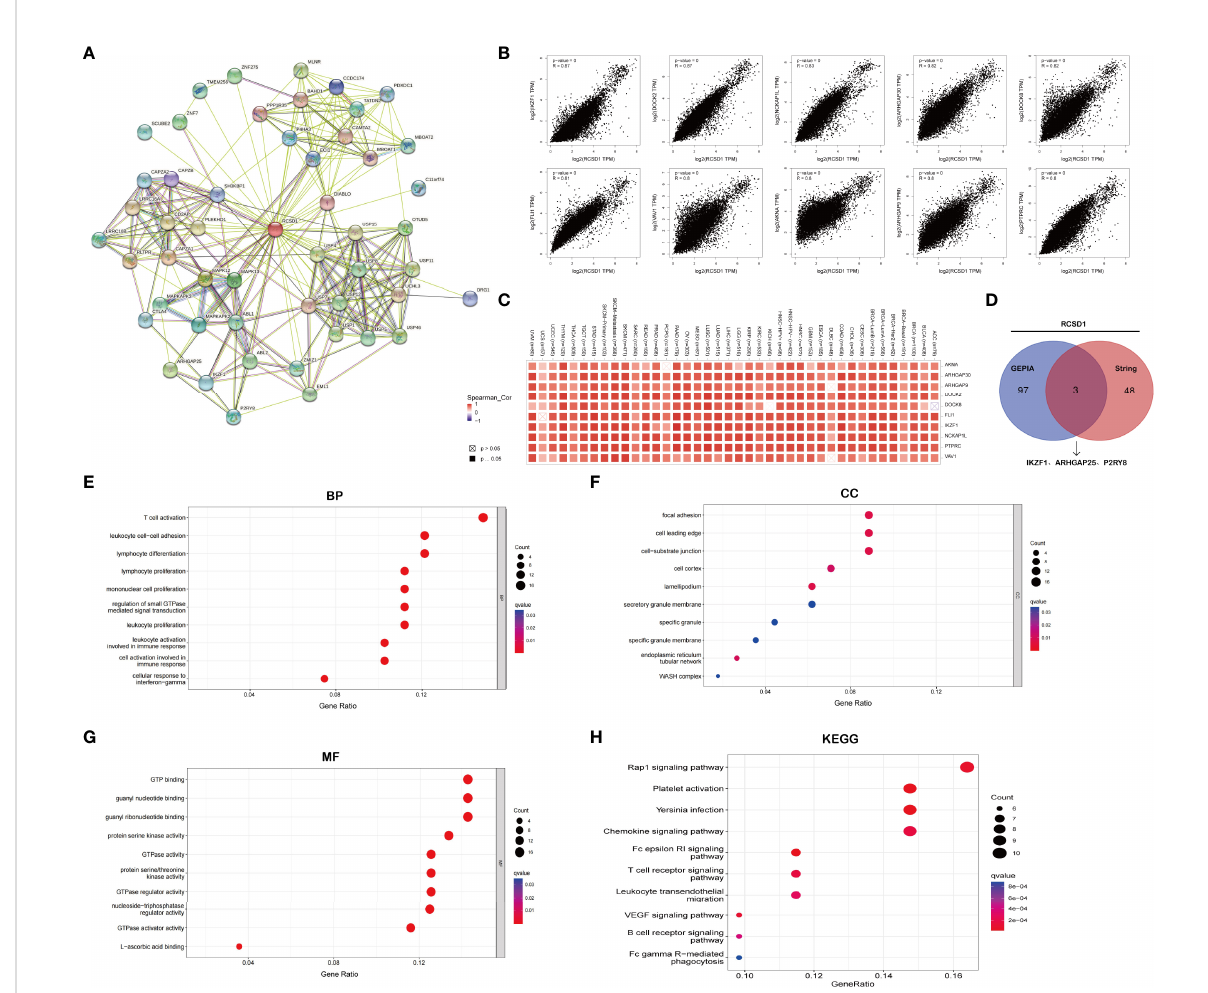
FIGURE 5 RCSD1 co-expression network. (A) RCSD1-binding proteins. (B) The correlation of top 10 RCSD1-correlated genes, including AKNA, ARHGAP30, ARHGAP9, DODK2, DODK8, FLI1, IKZF1, NCKAP1L, PTPRC and VAV1. (C) Correlation of RCSD1 with the 10 genes in human tumors. (D) VENN plots showing the cross-analysis of correlated genes. (E) GO_BP analysis. (F) GO_CC analysis. (G) GO_MF analysis. (H) KEGG pathway